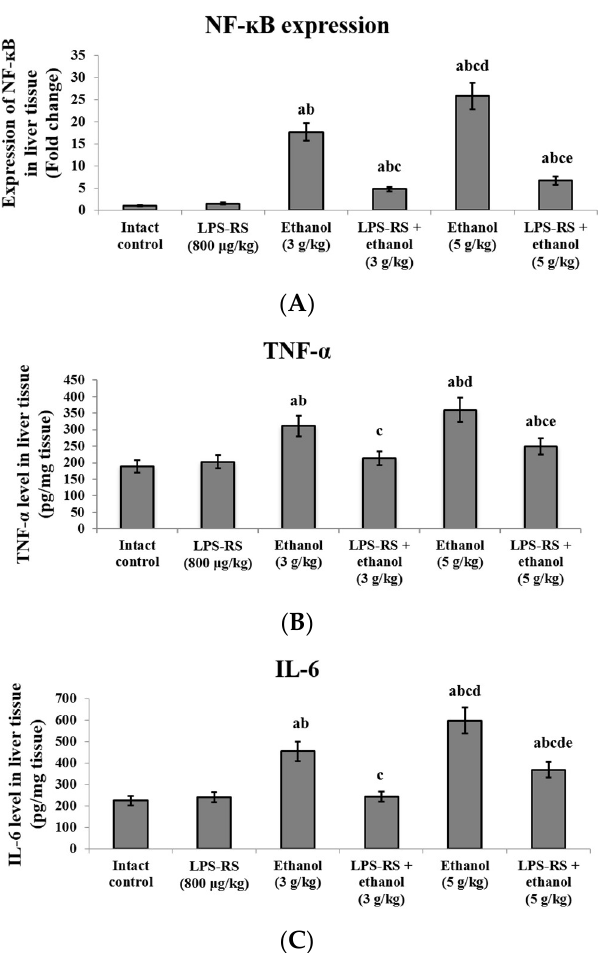
Figure 2. The effect of LPS-RS (800 μg/kg) on inflammatory markers in the liver tissue of the experimental rats. ( A ) the expression of NF-kB, ( B ) levels of TNF- α and ( C ) levels of IL-6. NF- κ B, nuclear factor kappa B; TNF- α , tumor necrosis factor-alpha; IL-6, interleukin-6. Data are expressed as mean ± SD and analyzed using one-way ANOVA followed by Bonferroni’s post-hoc test ( n = 8–10). Differences were considered significantly different at p < 0.05. a vs. intact control; b vs. LPS-RS; c vs. ethanol (3 g/kg); d vs. LPS-RS + ethanol (3 g/kg); e vs. ethanol (5 g/kg).